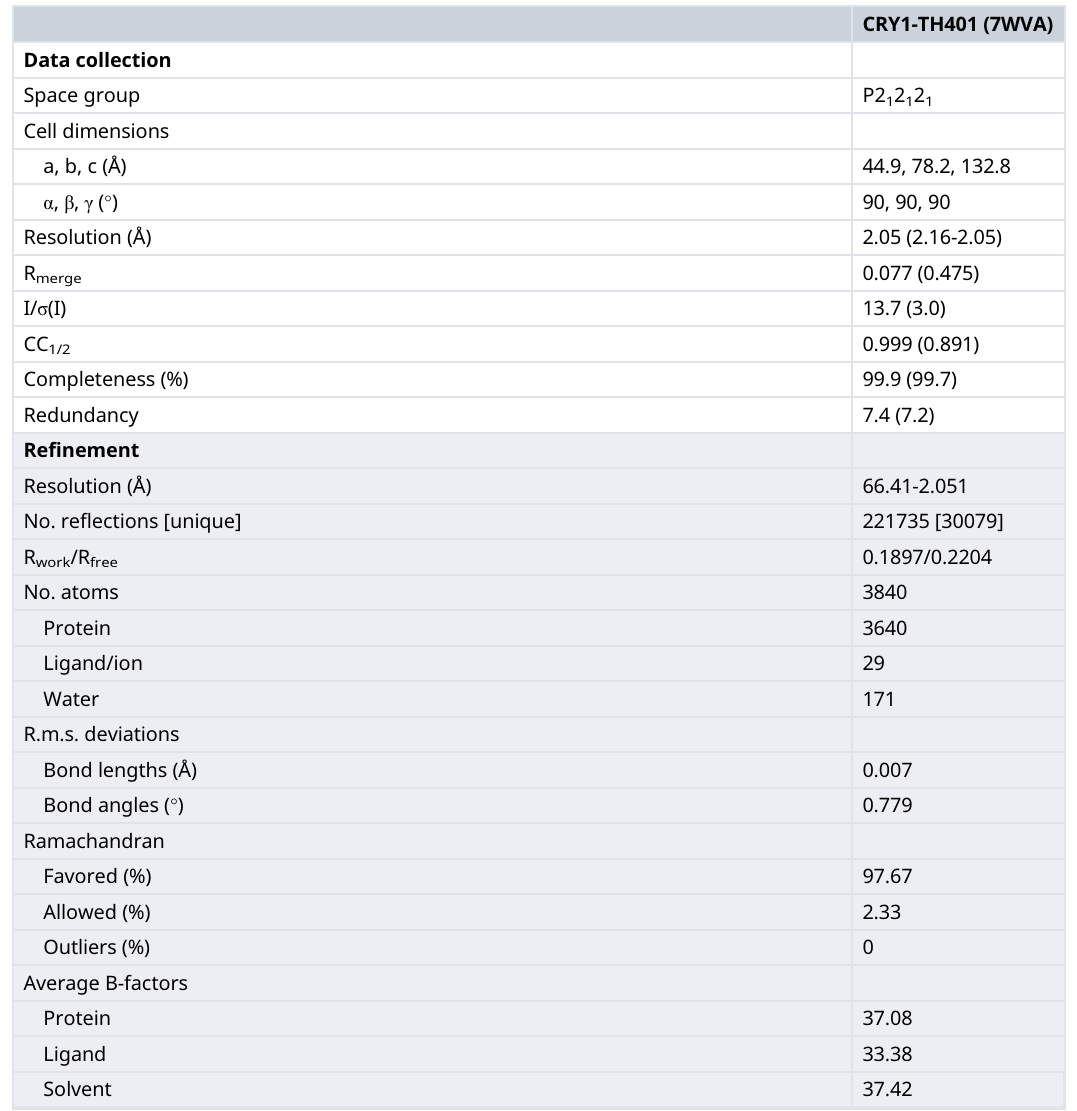
Table 1.Datacollectionandrefinement statistics. Values inparentheses areforthehighestresolution shell.Root mean square (R.m.s.); correlation coefficient